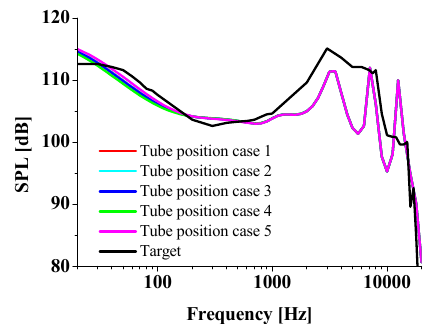
Figure 15. Acoustic tube position influence and target SPL (simulation result).